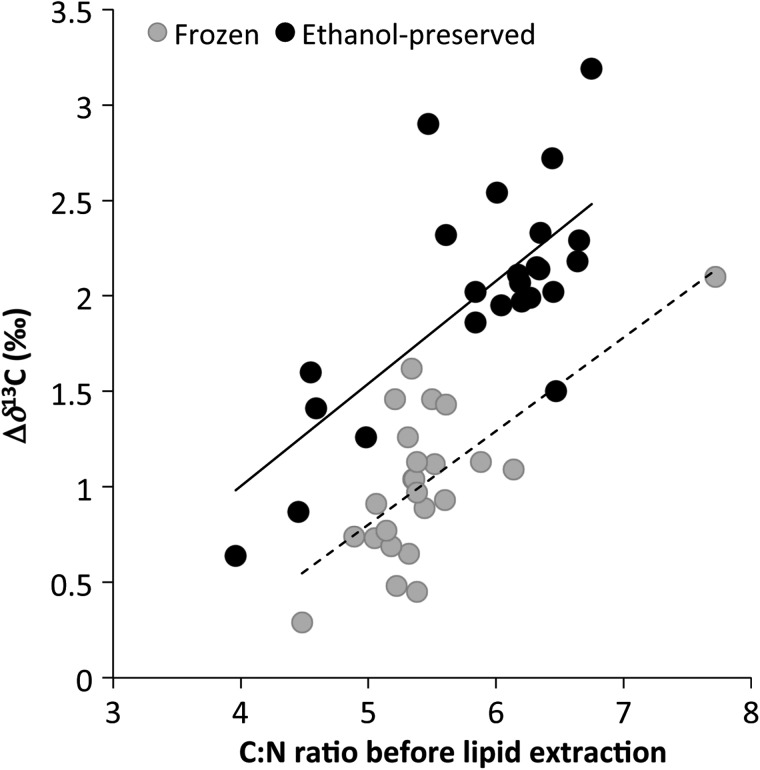
The change in δ13C values following lipid extraction (Δδ13C) is positively related to the C:N ratio prior to lipid extraction in both frozen and ethanol-preserved yolks. Both relationships are significant (P < 0.001), and equations are provided in Table 3.